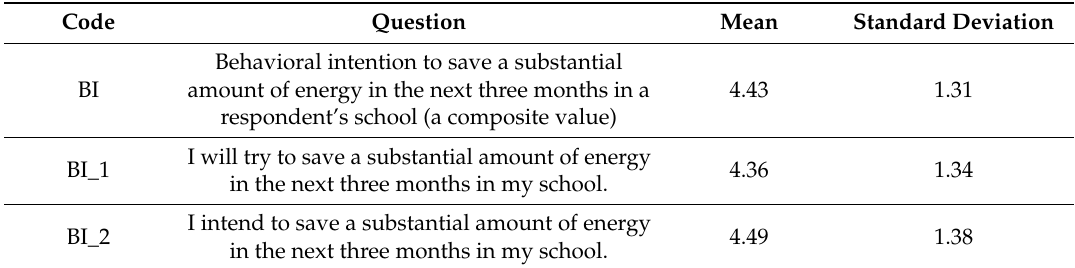
Table 7. Mean for behavioral intention (totally disagree (1) to completely agree (7)).